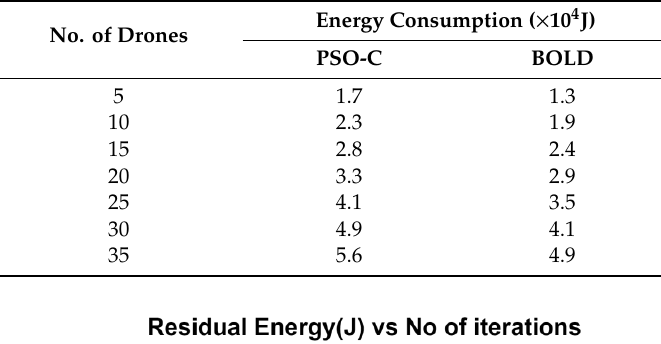
Table 5. Energy consumption (J) vs the number of drones (1 unit = 10 4 Joules).